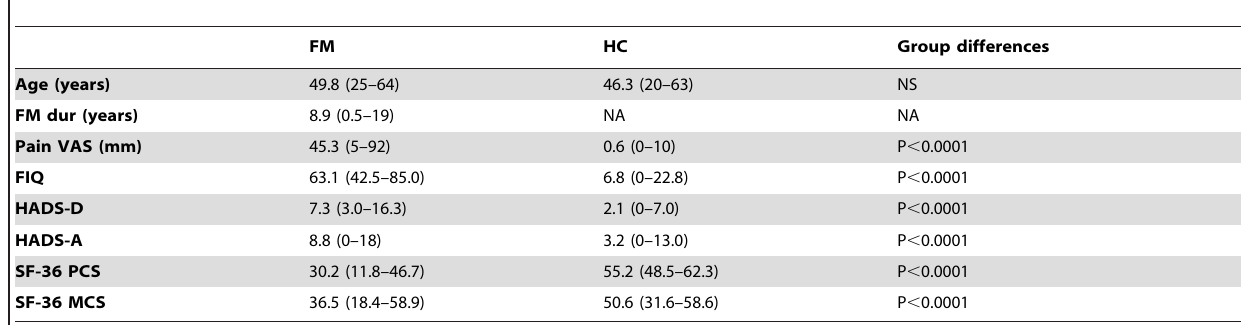
Table 1. Descriptive data for 29 FM patients and 31 HC, average values and range are